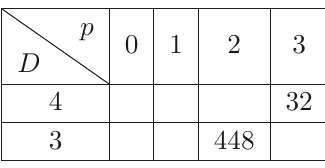
Table 7 . The H 10 , 6 , 2 family of branes.